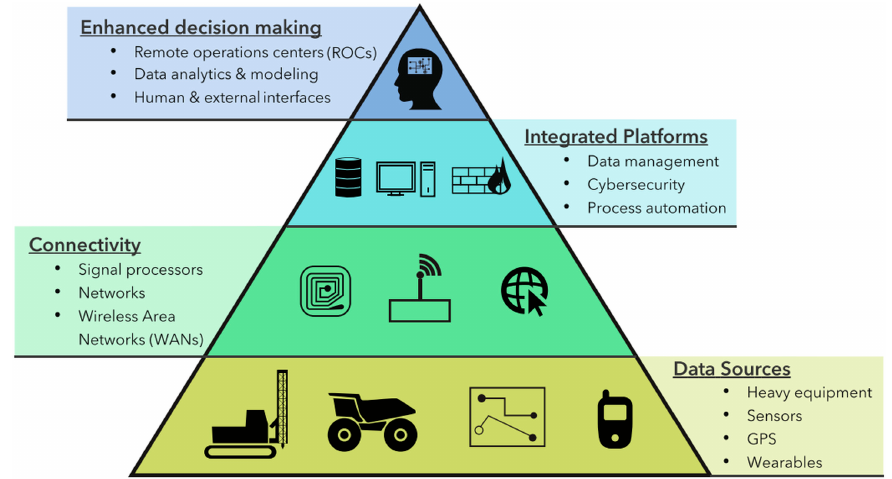
Figure 7. Digital ecosystem of mining company (Reprinted from Ref. [54]).